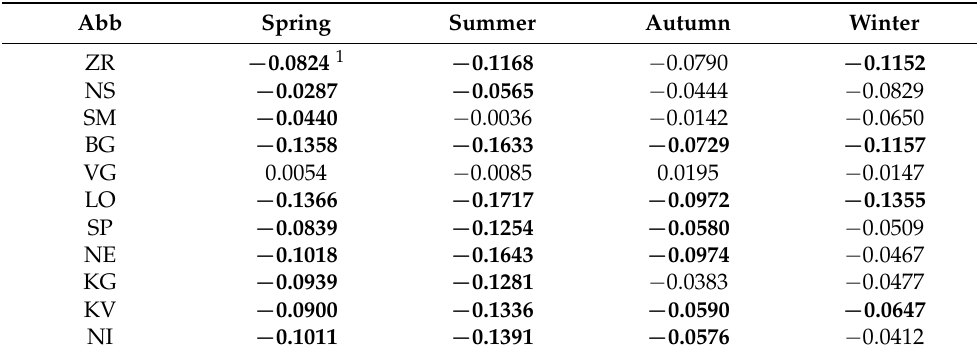
Table 6. Seasonal trend coefficients of Tn10 for 11 stations in Serbia from 1949 to 2018. Abb